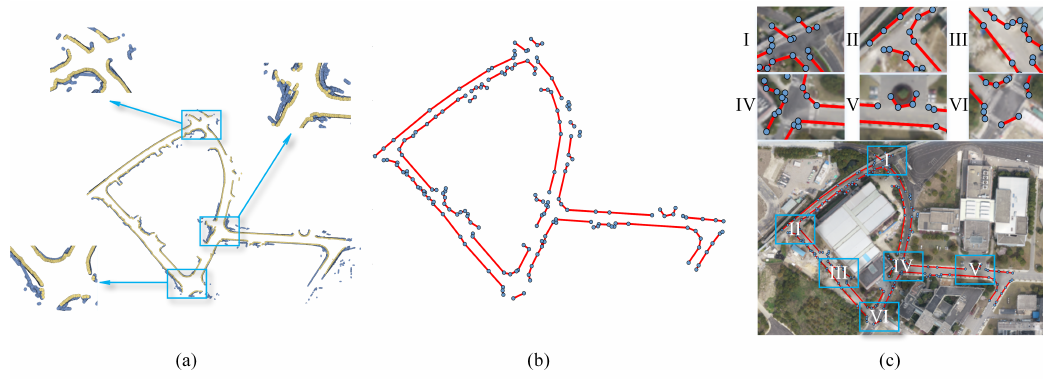
Figure 11. Experimental results of the proposed method on a loop road. ( a ) resulting road boundary points (blue) and innermost road boundary points (yellow). ( b ) resulting vectorized map obtained by the proposed method. ( c ) the superposition of the vectorized map obtained by the proposed method and aerial image of the mapped